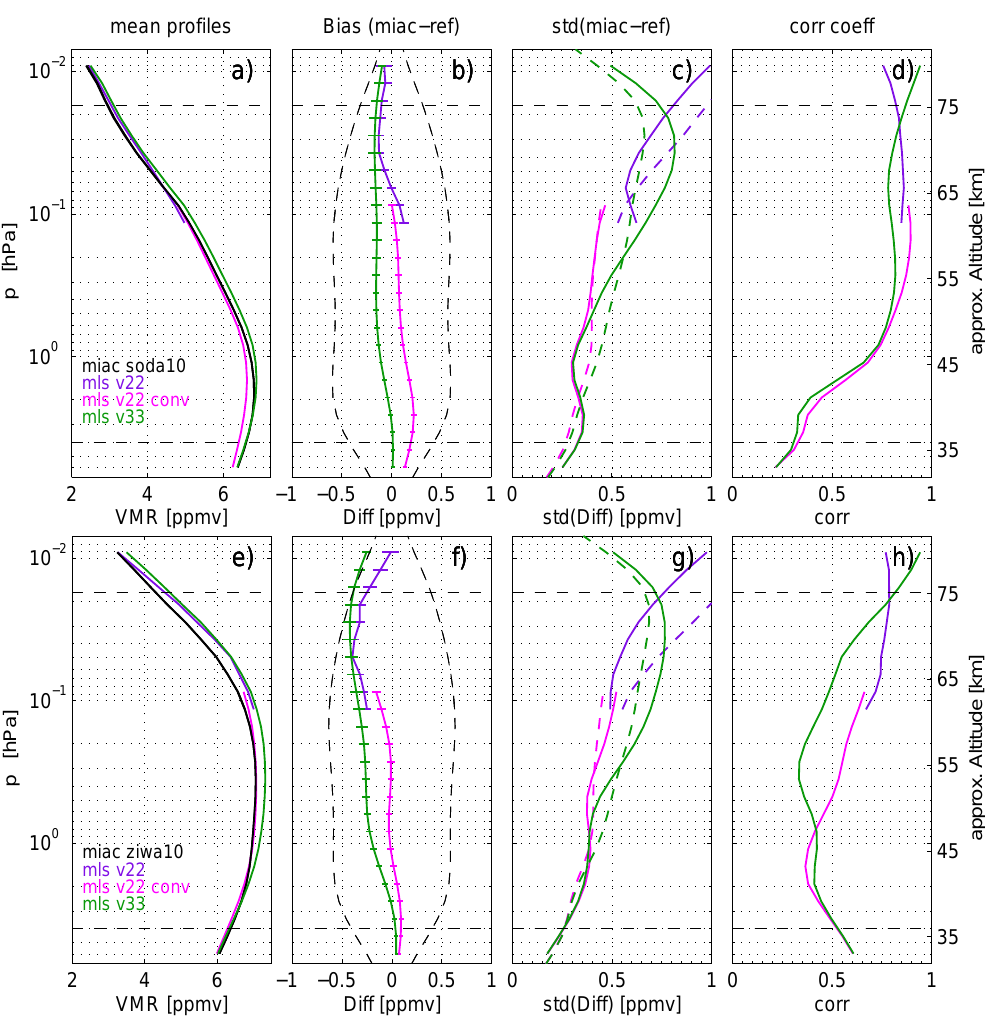
Fig. 9. Intercomparison MIAWARA-C (with correlation receiver) – MLS for Sodankyl¨a10 campaign (a–d) and for Zimmerwald10 (e–h) . (a, e) Mean coincident profiles of MLS v2.2 (pink: convolved, purple: interpolated), MLS v3.3 (green) and MIAWARA-C (black). (b, f) Bias (solid) with standard error (horizontal) with respect to MLS v2.2 (pink: convolved, purple: interpolated) and MLS v3.3 (green) together with the estimated systematic error of MIAWARA-C (black dashed). (c, g) Standard deviation of differences (solid; pink for MLS v2.2 convolved, purple for MLS v2.2 interpolated, green for MLS v3.3) and combined random error of the instruments (dashed). (d, h) correlation coefficients. All plots use MIAWARA-C data with AoA > 0.5. The dashed horizontal lines indicate the reliable altitude range (AoA >